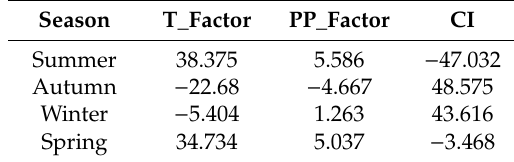
Table 3. Multiple regression parameter for the snow area